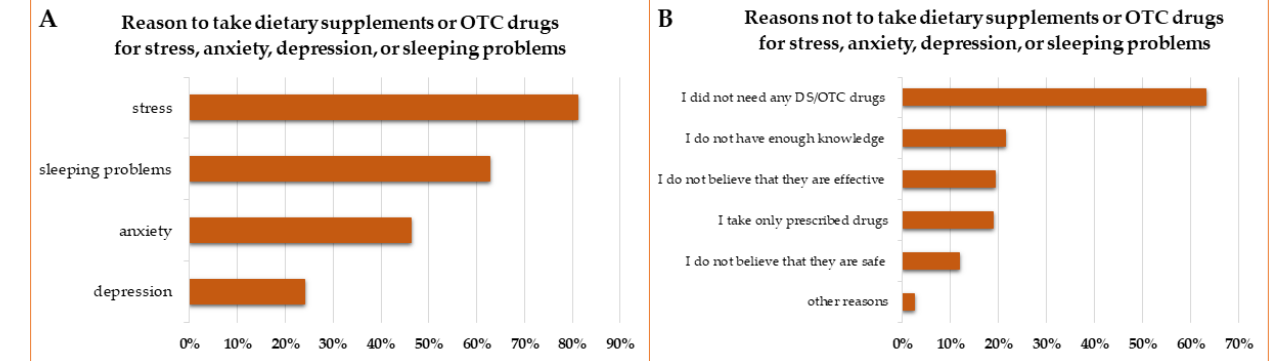
Figure 4. The reasons for choosing DS or OTC drugs for stress, anxiety, depression, or sleeping problems ( A ), the reasons not to take DS or OTC drugs for stress, anxiety, depression, or sleeping problems; some other reasons for not using DS or OTC drugs are mentioned in the main text ( B